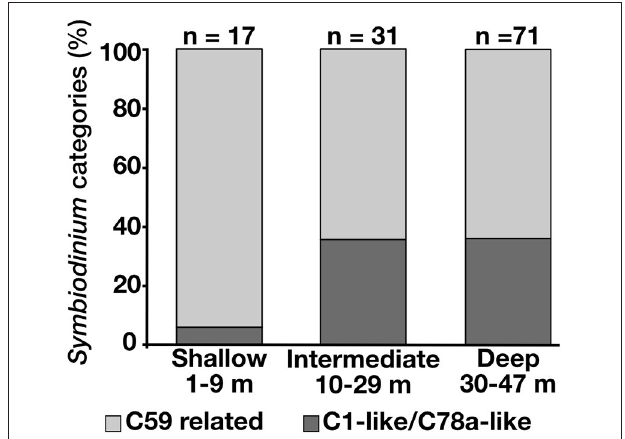
FIGURE 4 | Proportions of the C59-related Symbiodinium assemblages and of the C1-like/C78a-like Symbiodinium in Seriatopora at different